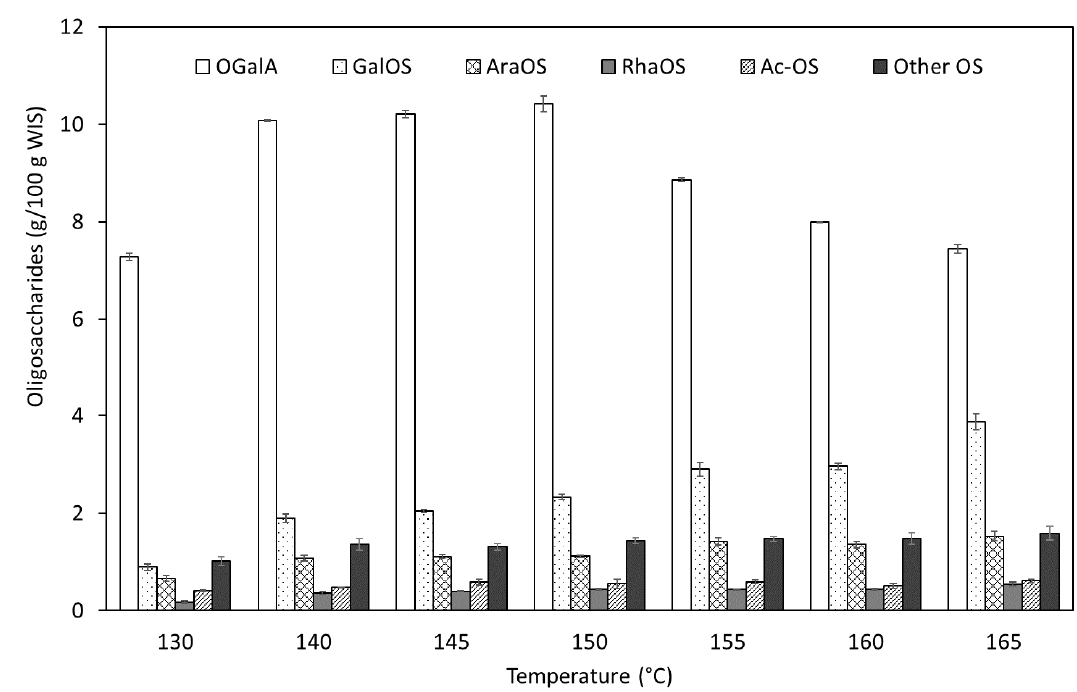
Figure 3. Temperature dependence of the oligosaccharides. OGalA: oligogalacturonides; GalOS: galactose units in oligosaccharides; AraOS: arabinose units in oligosaccharides; RhaOS: rhamnose units in oligosaccharides; Ac-OS: acetic acid units in oligosaccharides; OS: oligosaccharides.